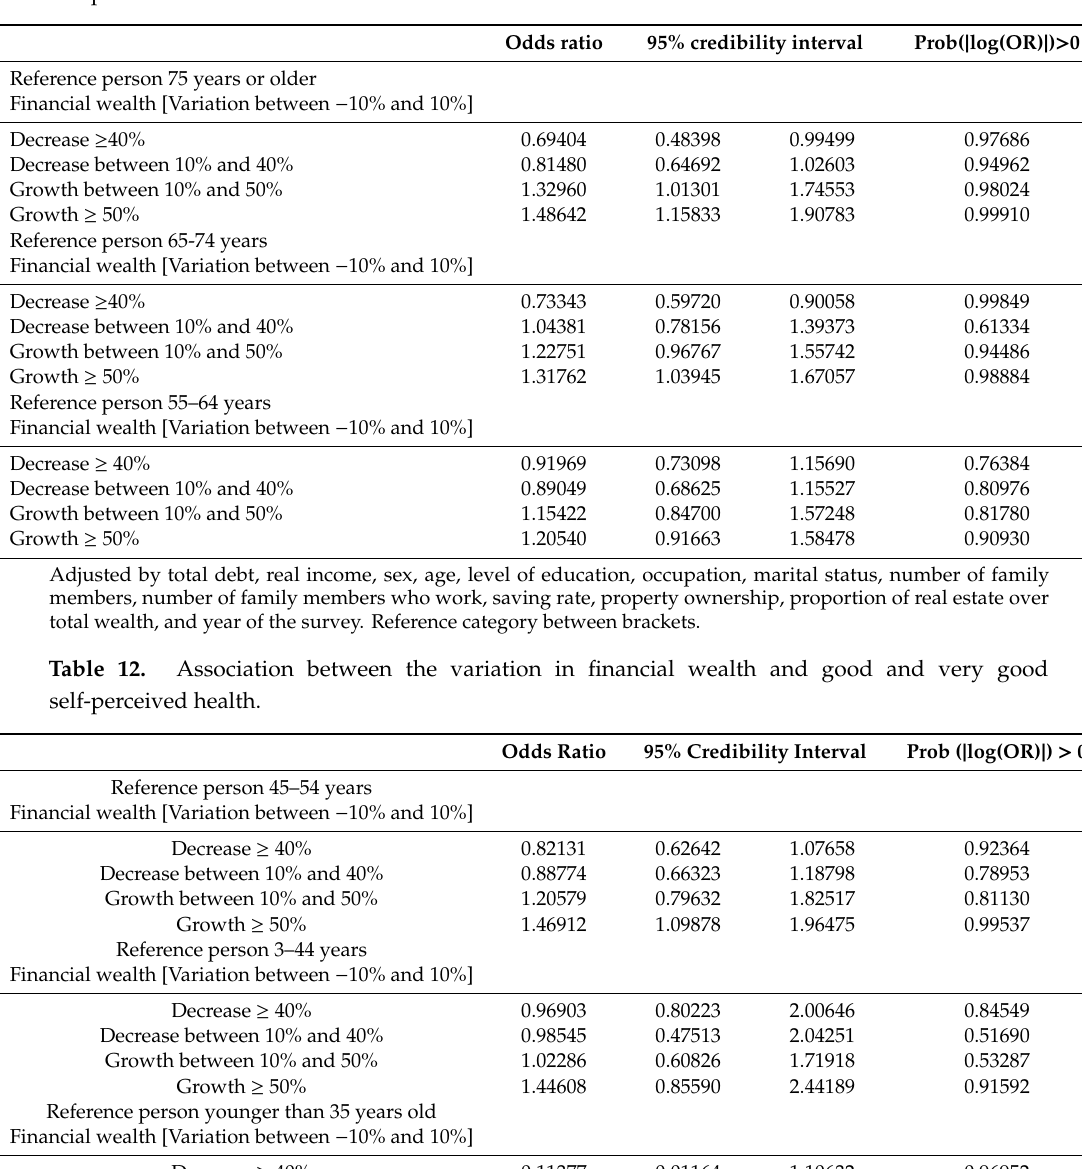
Table 11. Association between the variation in financial wealth and good and very good self-perceived health.